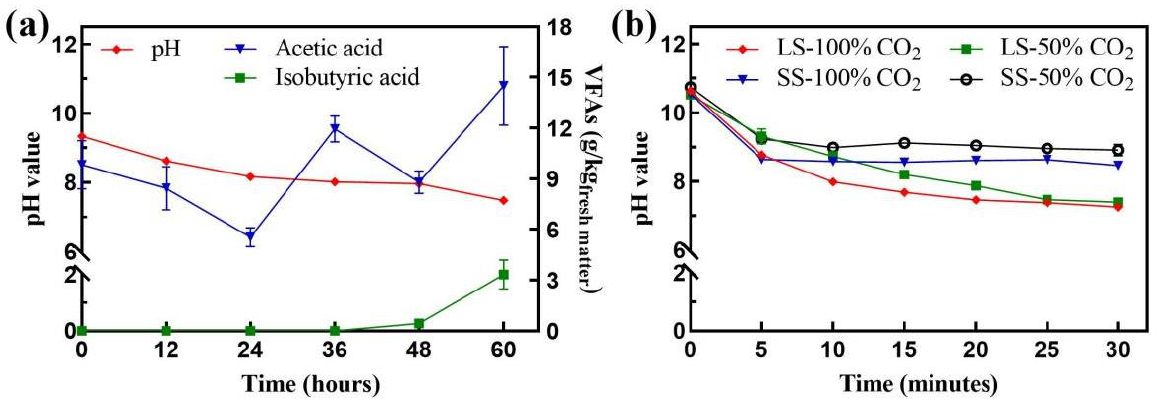
Figure 1. Changes in ( a ) pH and VFAs during LD-neutralization; and ( b ) pH during CO 2 -neutralization. LS- and SS-denote liquid state and solid state, respectively. Data are shown as mean ± standard deviation (SD), n = 3.